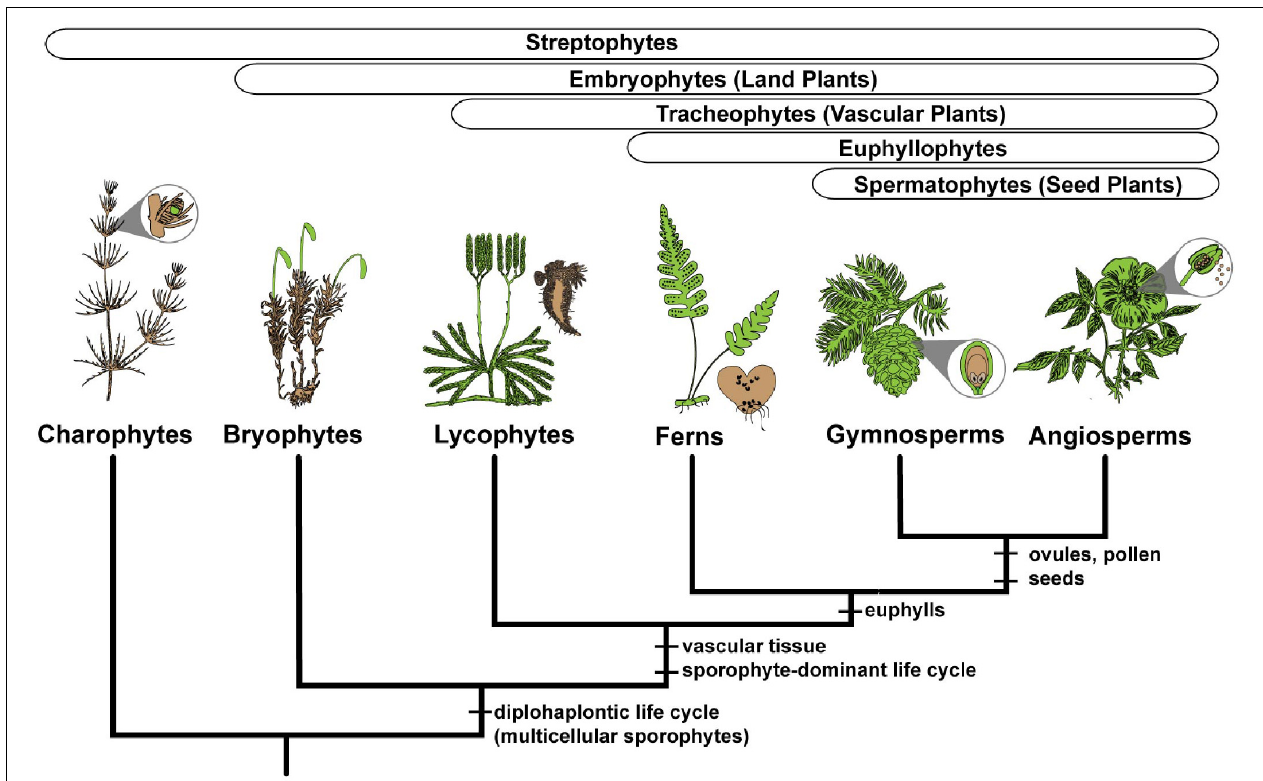
FIGURE 2 | Simplified phylogeny of the major clades of streptophyte plants, illustrating the gametophyte (colored brown) and sporophyte (colored green) phases for exemplar lineages. Charophyte algae have a multicellular gametophyte and a single celled sporophyte. All embryophytes, or land plants, have multicellular gametophytes and multicellular sporophytes. Synapomorphies are shown for the major